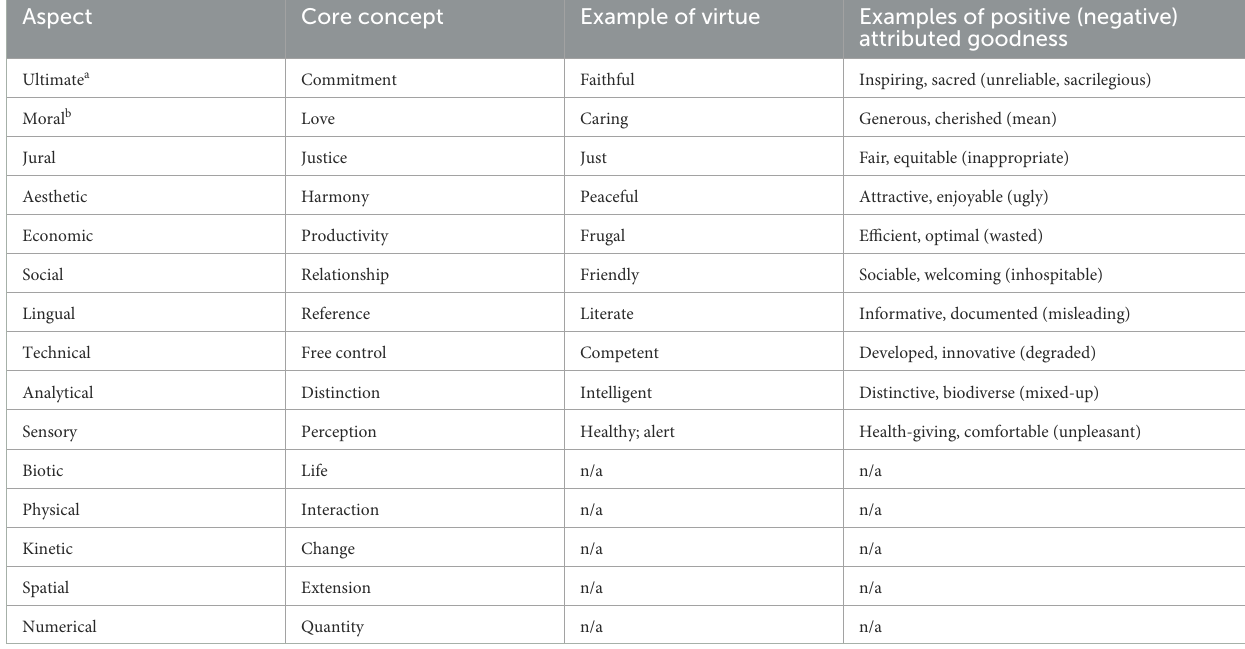
TABLE 1 The aspects proposed by Dooyeweerd and Vollenhoven, with core concepts (often “values”), active forms (“virtues”) and associated goodness attributes (kinds of “value”).